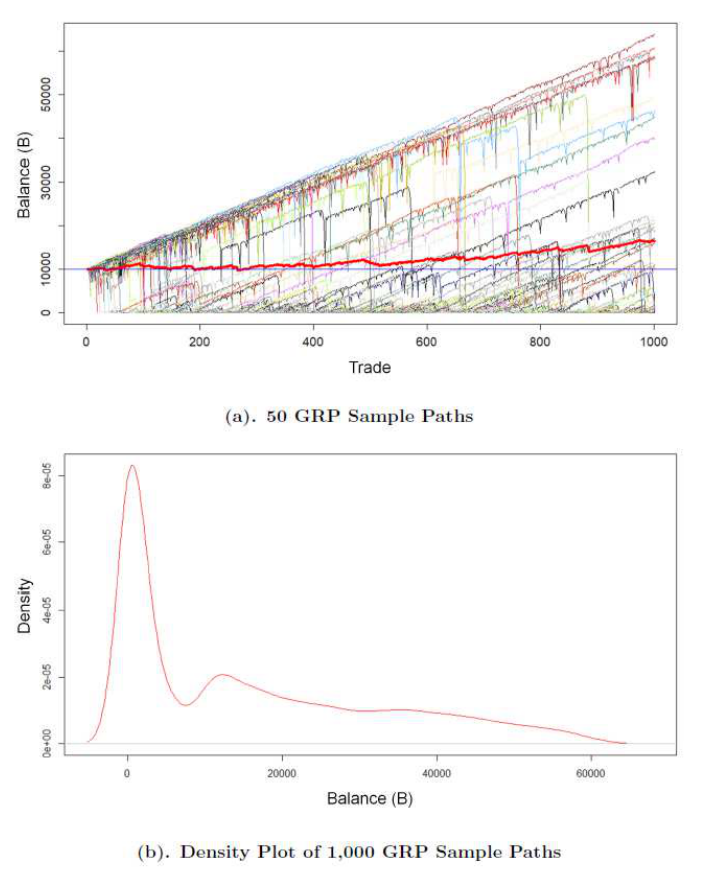
Figure 6. Multiple GRP